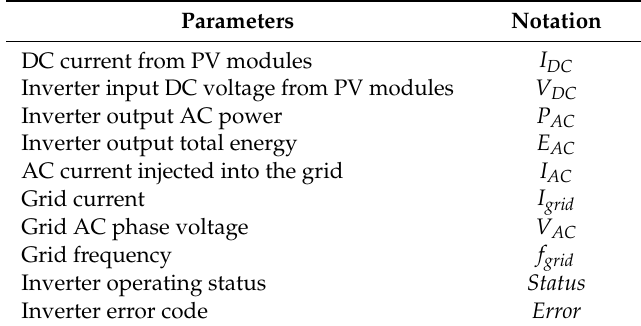
Table 1. Analyzed parameters measured by